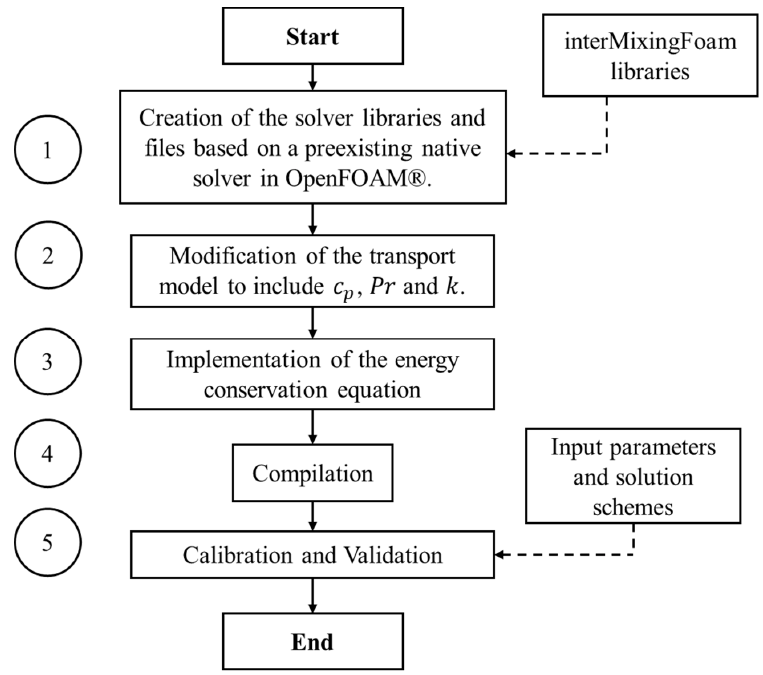
Figure 1. Flow chart of the interMixingTemperatureFoam (IMTF) solver development for OpenFOAM ® .